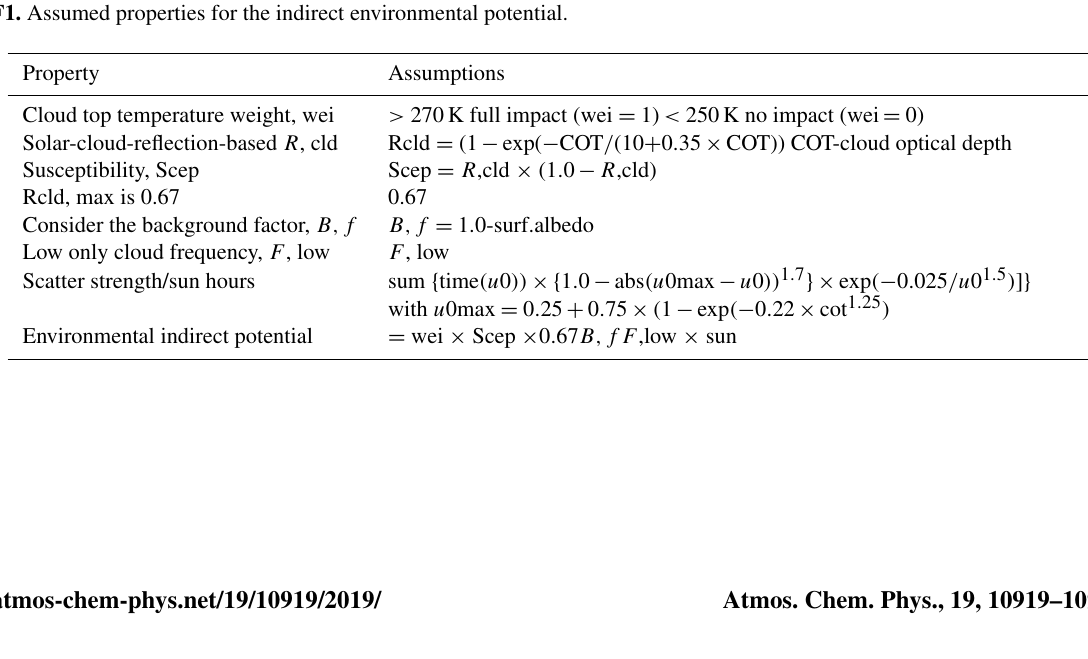
Table F1. Assumed properties for the indirect environmental